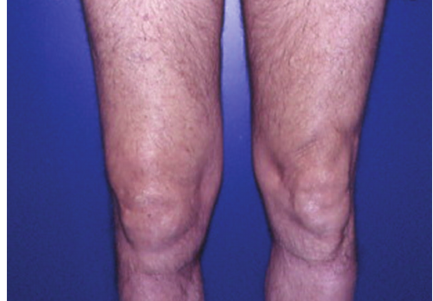
Figure 5: Articular involvement in Lyme